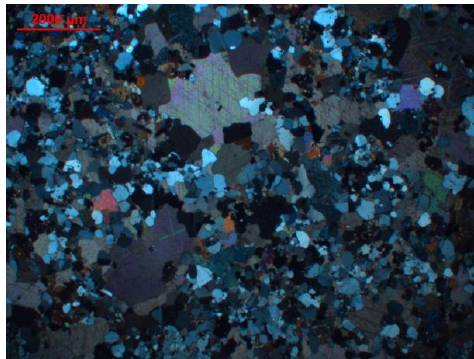
Figure 6. Thin section identification of rock samples in the test area.